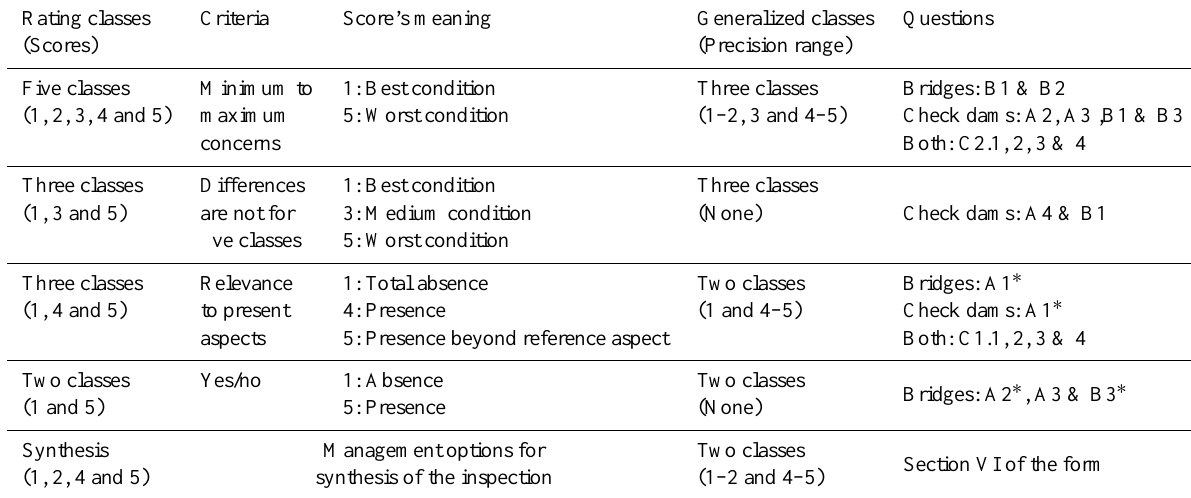
Table 3. Rating scales used in the inspection